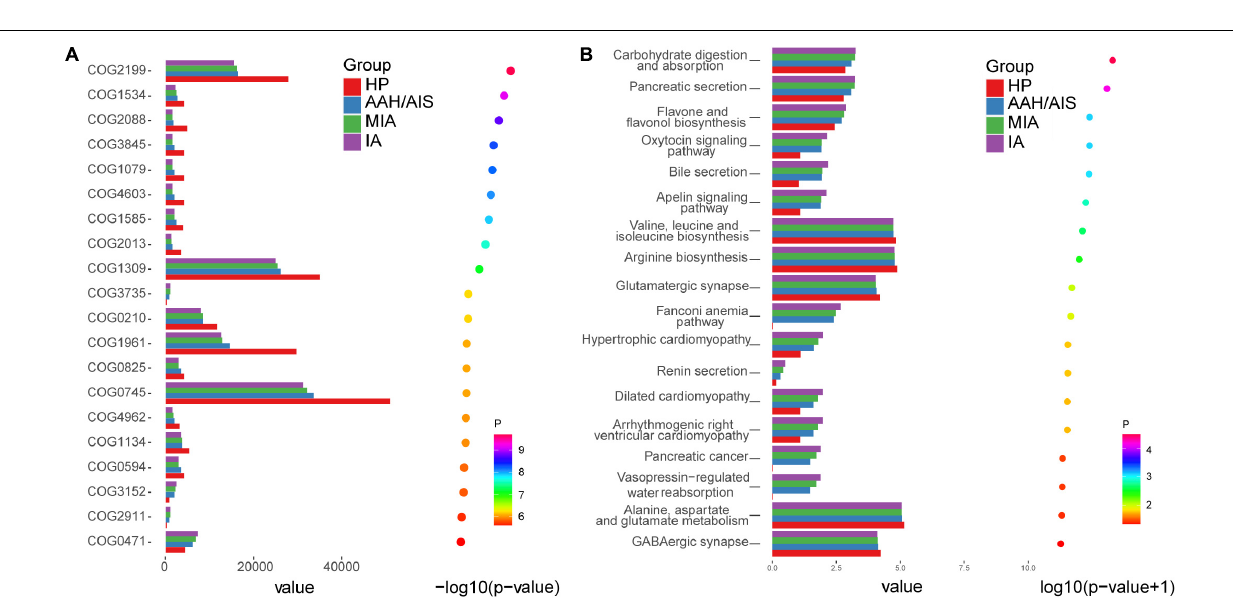
Frontiers in Microbiology |